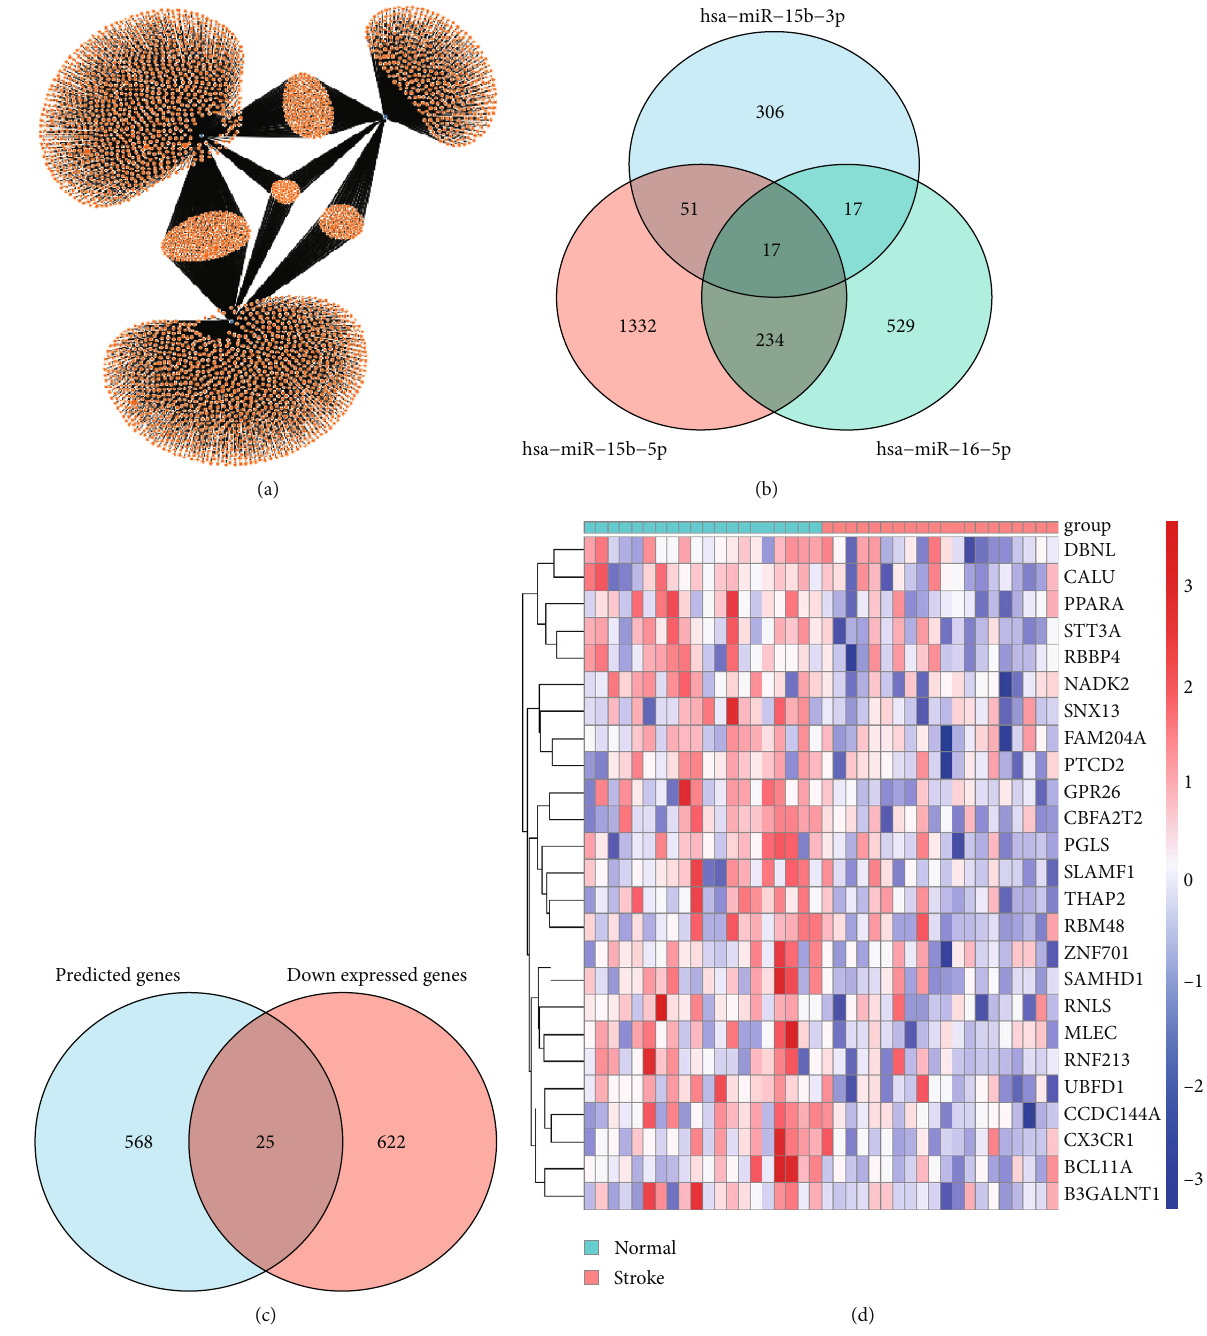
Figure 2: Construction of miRNA-mRNA Network. (a) The miRNA-target gene network for di ff erentially expressed miRNAs. (b) Venn diagram showing the overlap among the predicted targets of the di ff erentially expressed miRNAs. (c) Venn diagram showing the overlap between down-regulated expressed genes and predicted targets of the di ff erentially expressed miRNAs. (d) Heat map of the 25 intersected